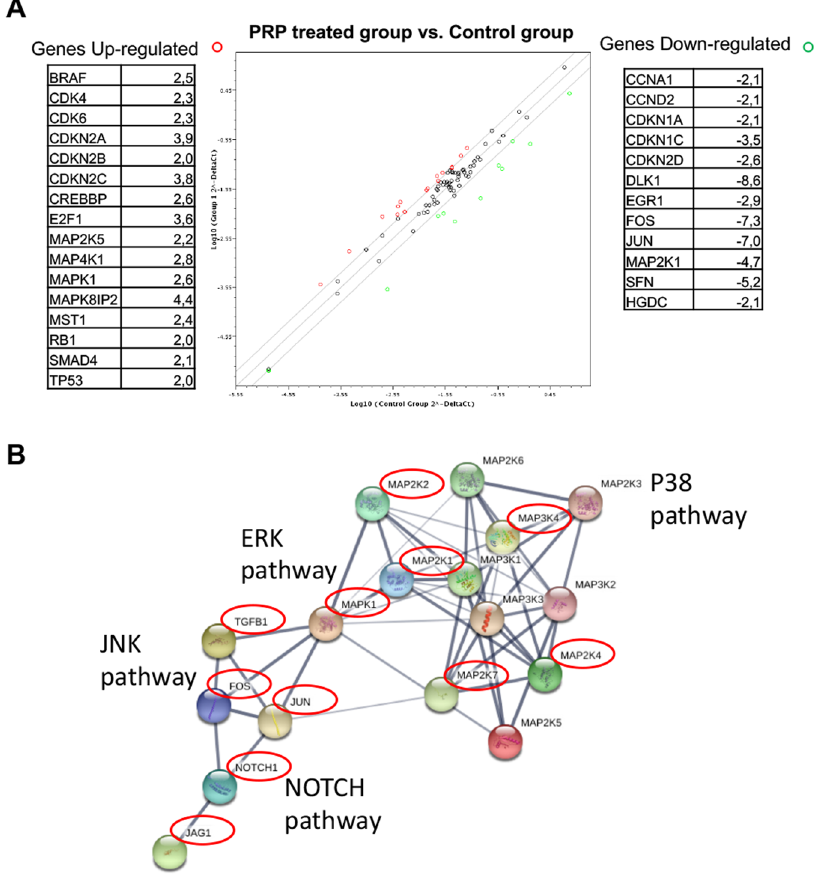
Figure 4. Screening of MAP Kinase Signalling Pathway genes by RT 2 Profiler PCR Array. ( A ) BxPC3 CSCs were treated with PRP on day 2 and on day 4. On day 5, total RNA from treated and non-treated CSCs were extracted. A pool of three total RNAs extracted from three independent experiments was used for first strand cDNA synthesis. Gene expression was determined using MAP Kinase Signalling Pathway RT 2 Profiler PCR Array. Sixteen genes were up-regulated, whereas twelve were downregulated compared to the controls. ( B ) Functional in-silico analysis of proteins related to the c-Jun N-terminal kinase (JNK) pathway. Grey lines represent protein-protein associations, line thickness indicates the strength of data support (active interaction sources from experimental and database only). Red circles highlights genes coding for those proteins that were downregulated by PRP